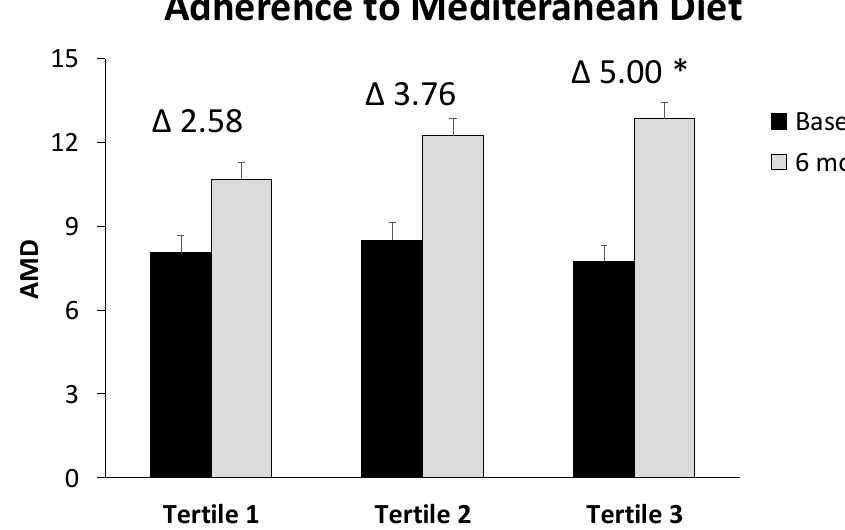
Figure 2. Values are the mean ± SD. Difference in means of ADM classified in tertiles was tested with one-factor ANOVA and Bonferroni’s post hoc analysis when variables followed a normal distribution or with Kruskal–Wallis test for non-normally distributed variables. * Differences with respect to tertile 1.